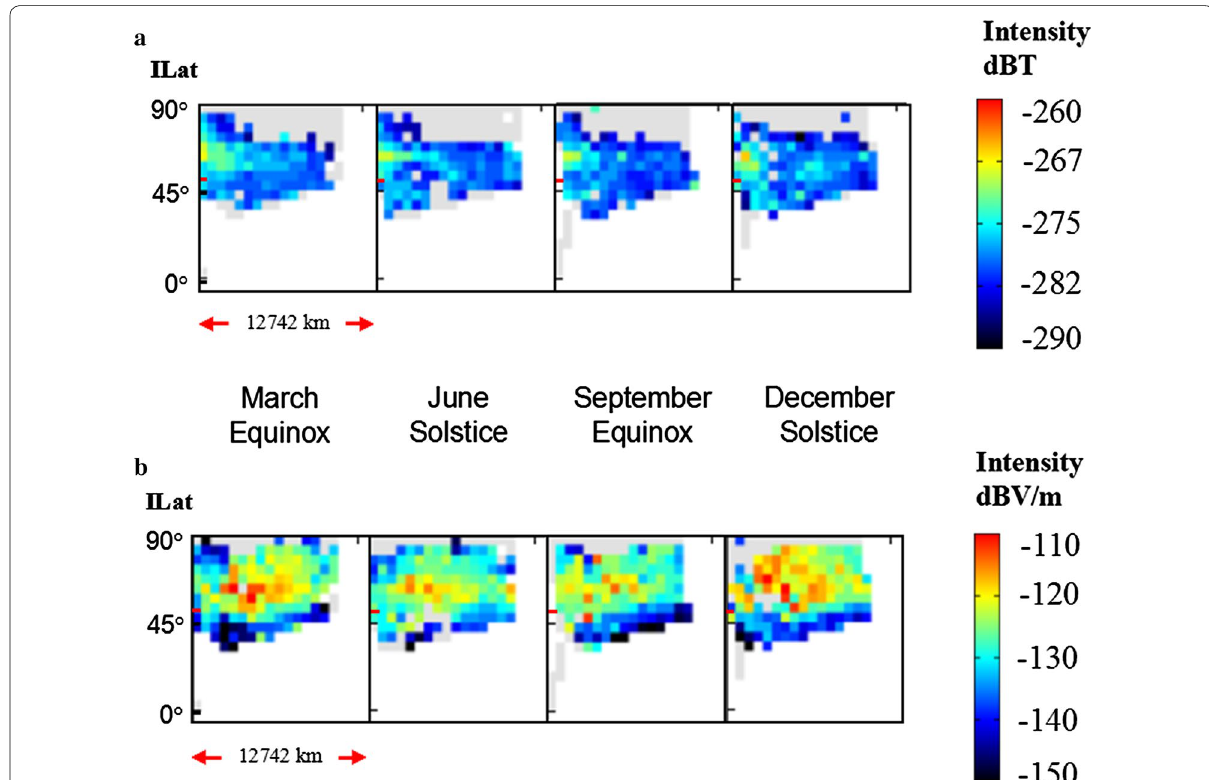
Fig. 9 a Seasonal propagation of the Omega signal from the Norway station in the magnetic field and b in the electric field based on invariant latitude and the propagation distance from the Earth’s